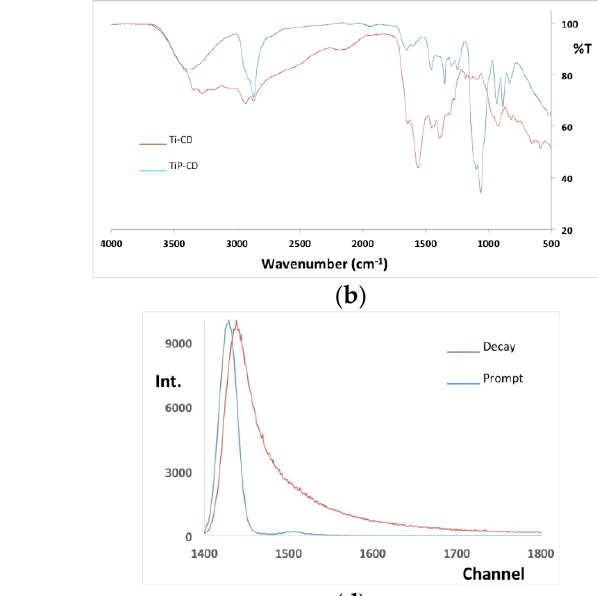
Figure 6. SEM images of the Ti-CD ( a ) and TiP-CD ( b , c ) samples and the corresponding EDS (Ti-CD ( d ) and TiP-CD ( e )).